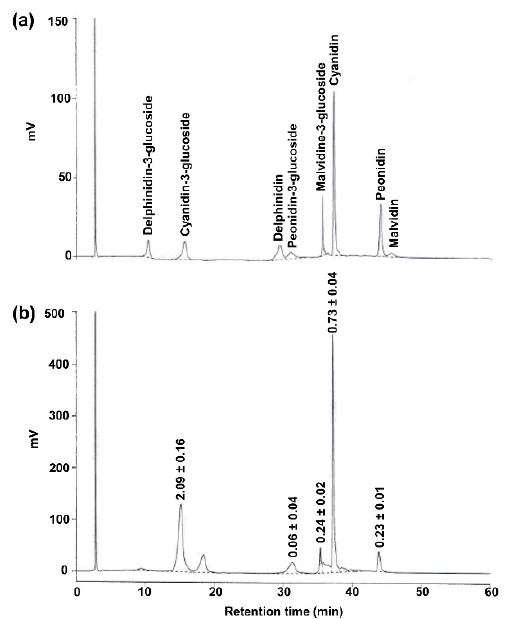
Figure 2. HPLC chromatogram at 520 nm showing major anthocyanins of purple rice husk extract. ( a ) Reference standards; ( b ) purple rice husk extract. The chromatographic peaks of the extract were confirmed by comparing their retention time and UV spectra with those of the reference standards. Numerical values denote the amount of individual compounds detected. Data (mean ± SD, n = 3) are expressed in mg/g of the extract.